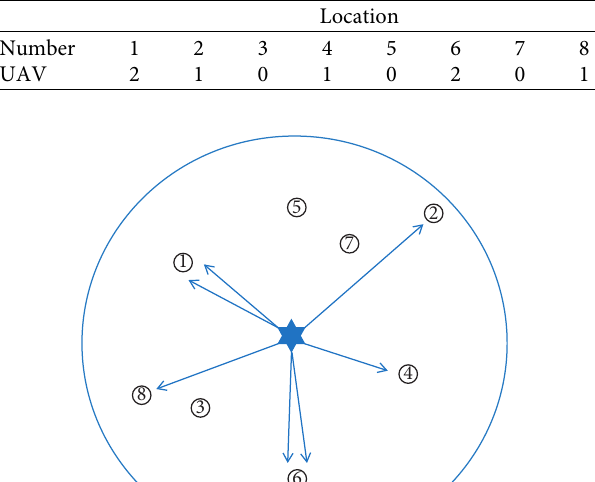
Table 4: The first assignment matrix L .